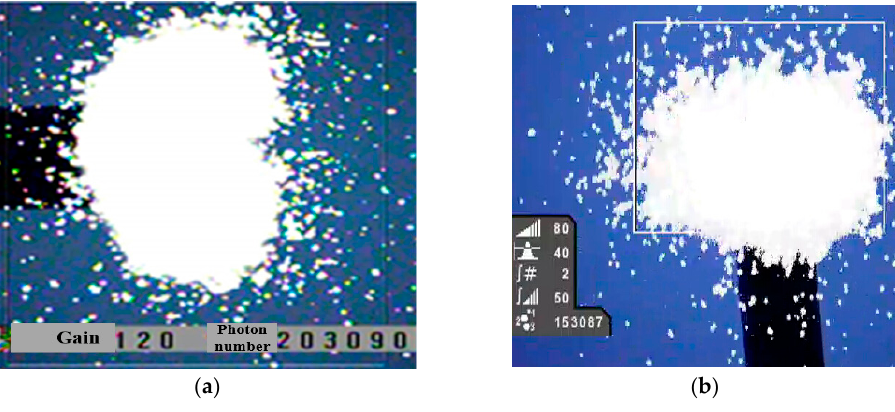
Figure 16. Detection image. ( a ) Type A; ( b ) Type B. Table 9. Test results.